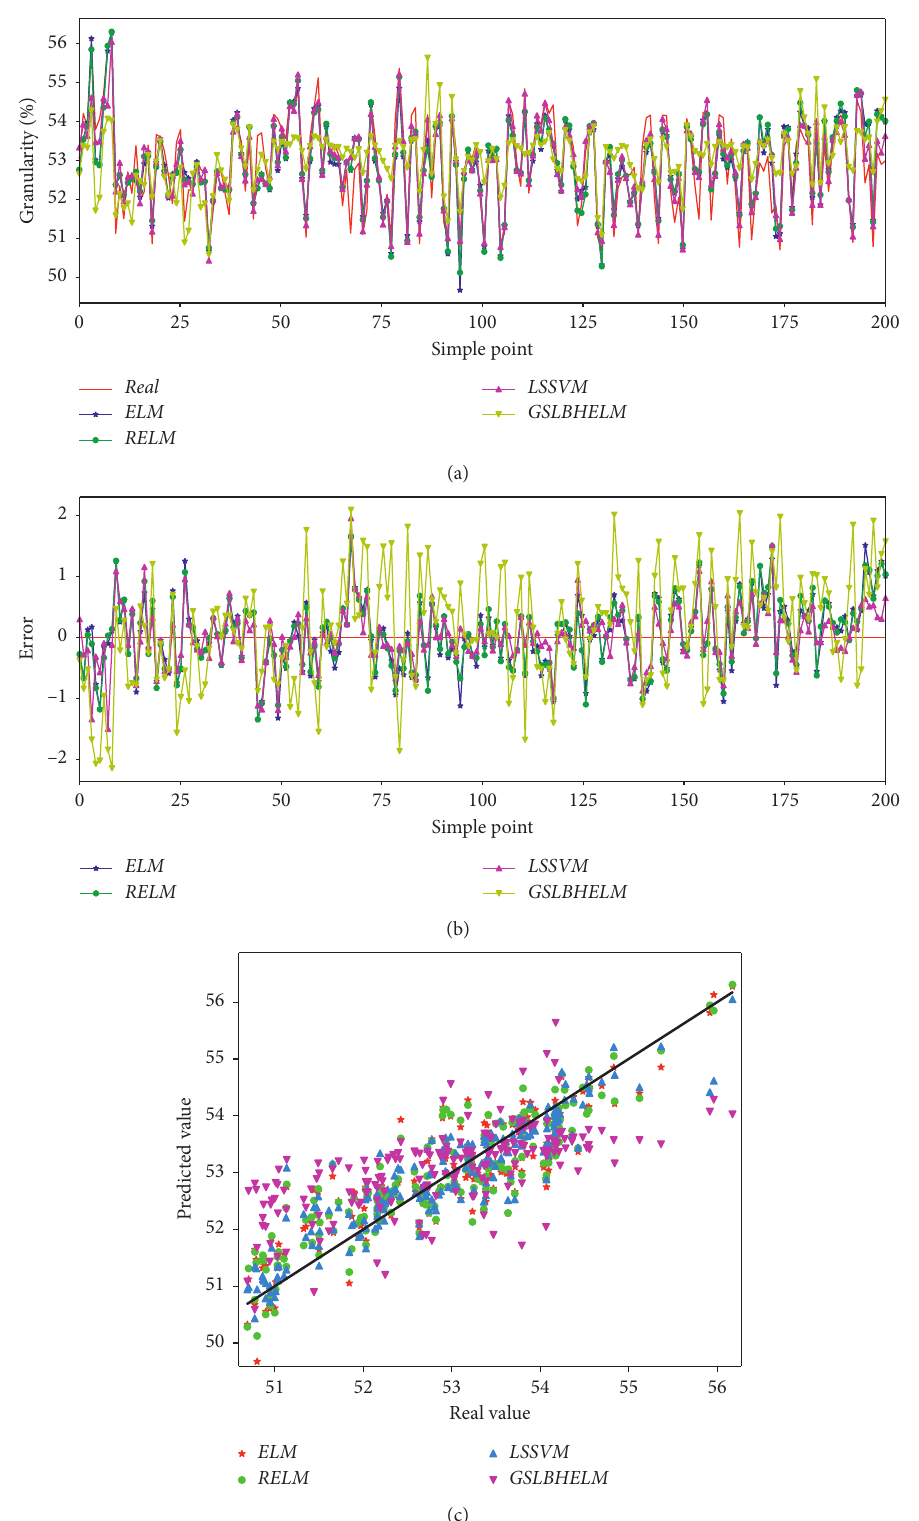
Figure 12: Experimental results under different ELM and LSSVM models. (a) Prediction results under different soft-sensor models. (b) Prediction errors under different soft-sensor models. (c) Predicted scatter plots under different soft-sensor